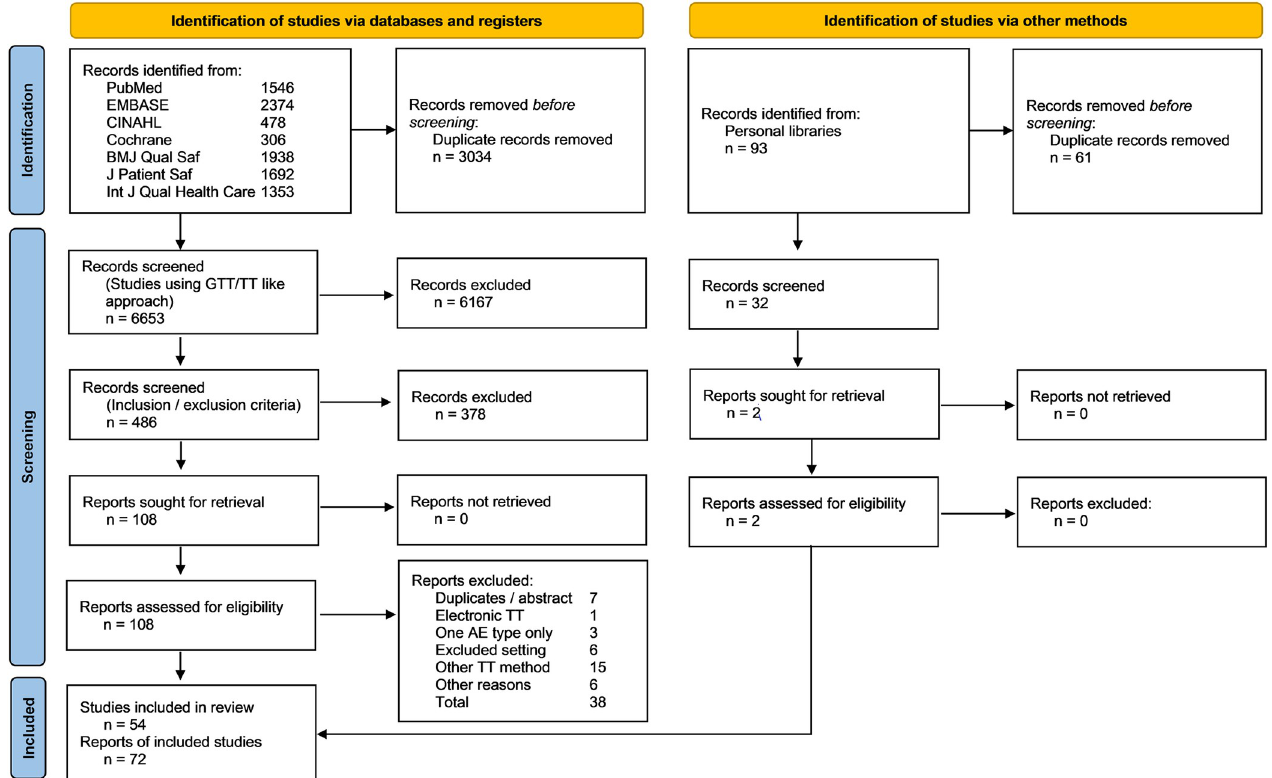
Fig 1. Flow diagram of literature search and included studies. From [27] (GTT, Global Trigger Tool, TT, Trigger Tool).